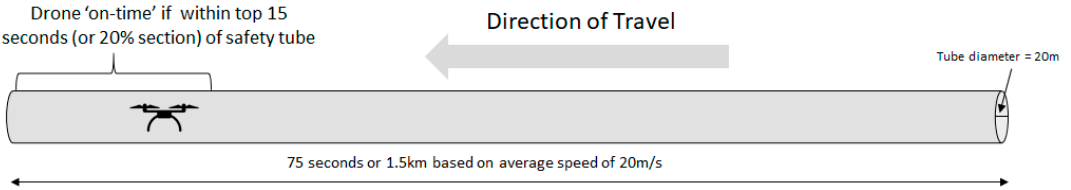
Figure 12. Drone safety tube—drone is travelling from east to west, with drone located in the forward 20% of the tube, indicating it is on time.